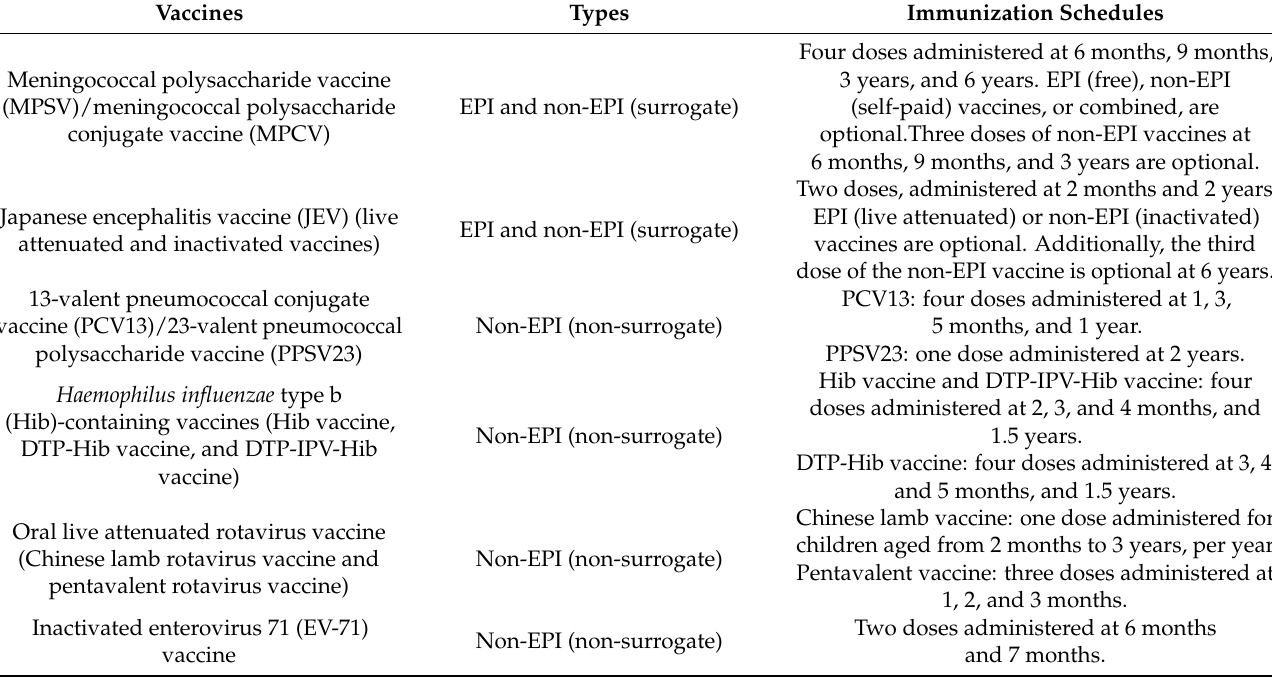
Table 1. Immunization schedules of six vaccines that may prevent meningitis/encephalitis in children.